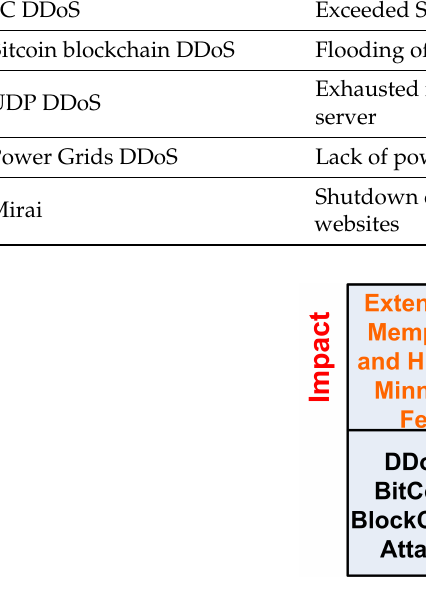
Figure 2. After Effects of DDoS